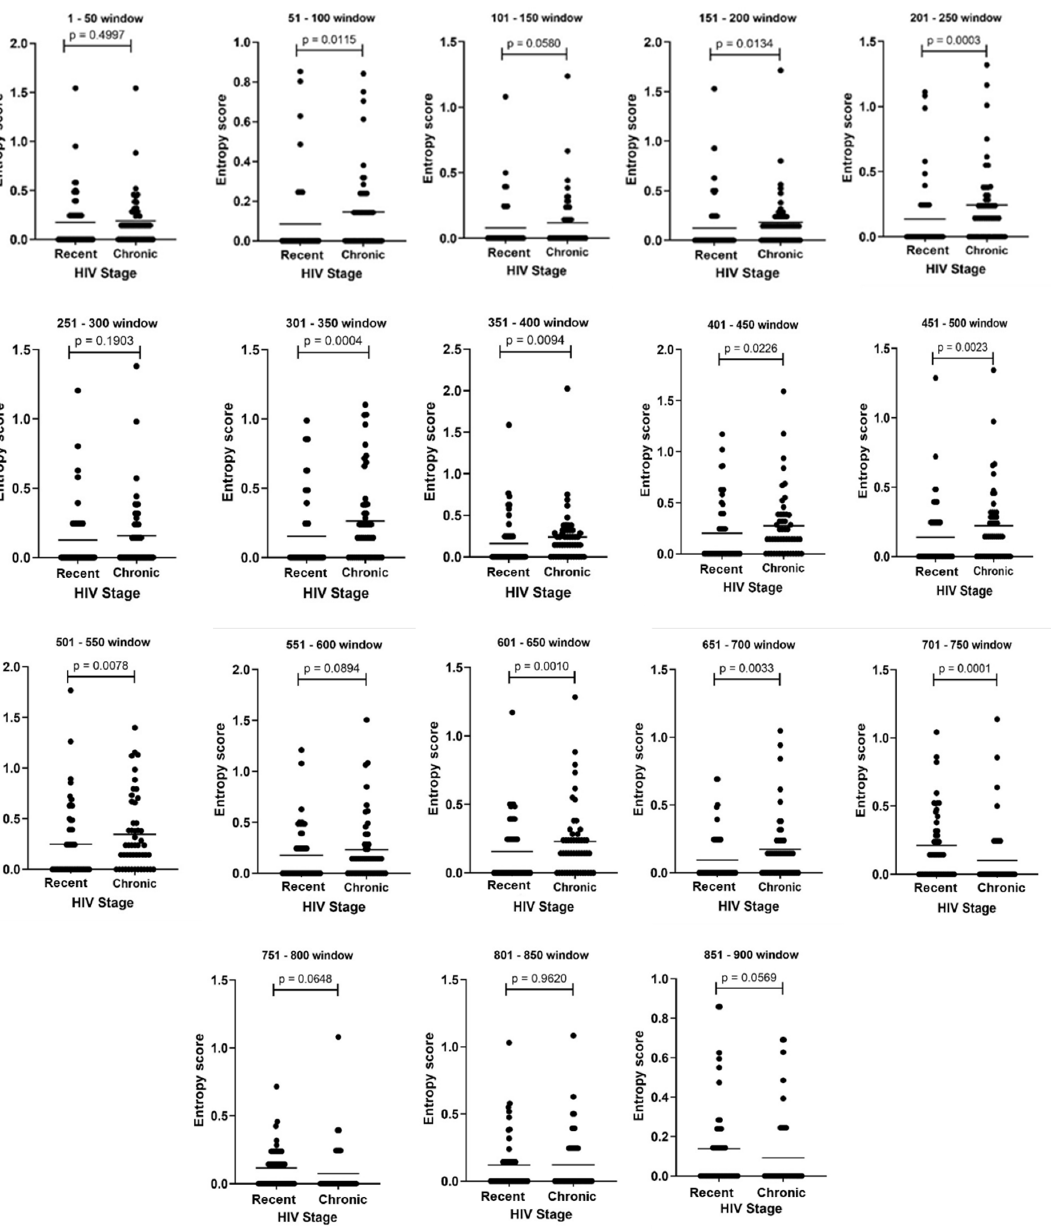
Figure 2. Scatterplots of sliding windows (containing 50 amino acids each) used to screen for in- formative areas that can differentiate recent from chronic infection. The following windows had significantly higher median entropy scores between recent and chronic HIV disease stages: 51–100, 151–200, 201–250, 301–350, 351–400, 401–450, 451–500, 501–550, 601–650, 651–700 and 701–750. Scat- terplots were created using GraphPad Prism. HIV = Human immunodeficiency virus. Scatterplots were created using GraphPad Prism. HIV = Human immunodeficiency